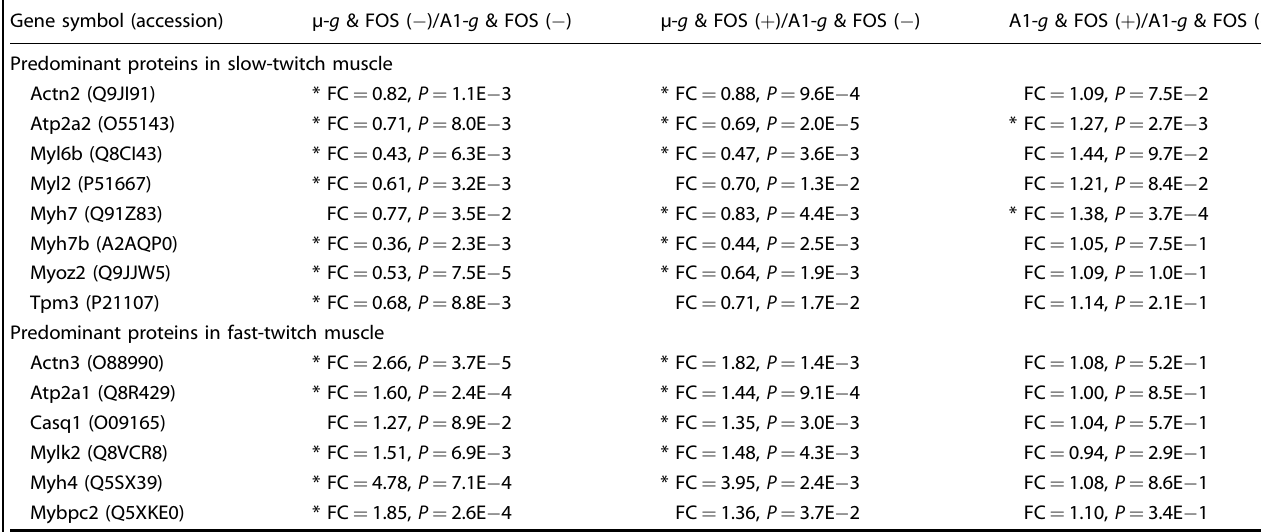
Table 5. Responses of soleus (Sol) muscle proteins composing sarcomere and affecting muscle contractile properties to microgravity (µ- g ) or arti fi cial 1- g (A1- g ) exposure and/or fructo-oligosaccharide (FOS) ingestion.